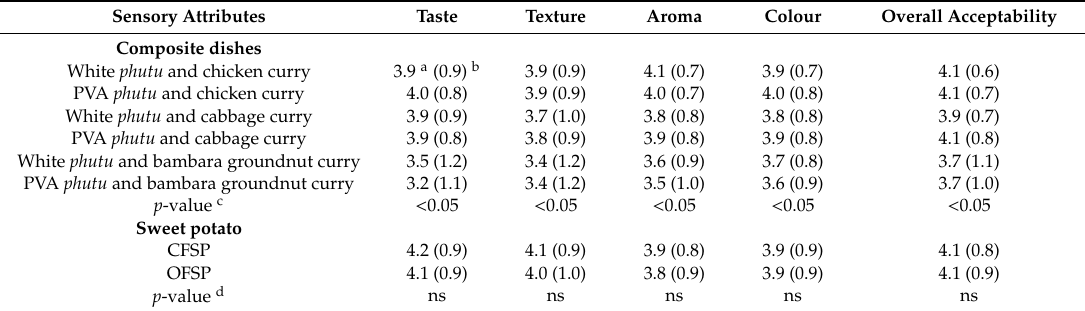
Table 6. Mean scores for the sensory evaluation of PVA-biofortified maize and OFSP dishes compared with the control white maize and CFSP dishes ( n = 120)